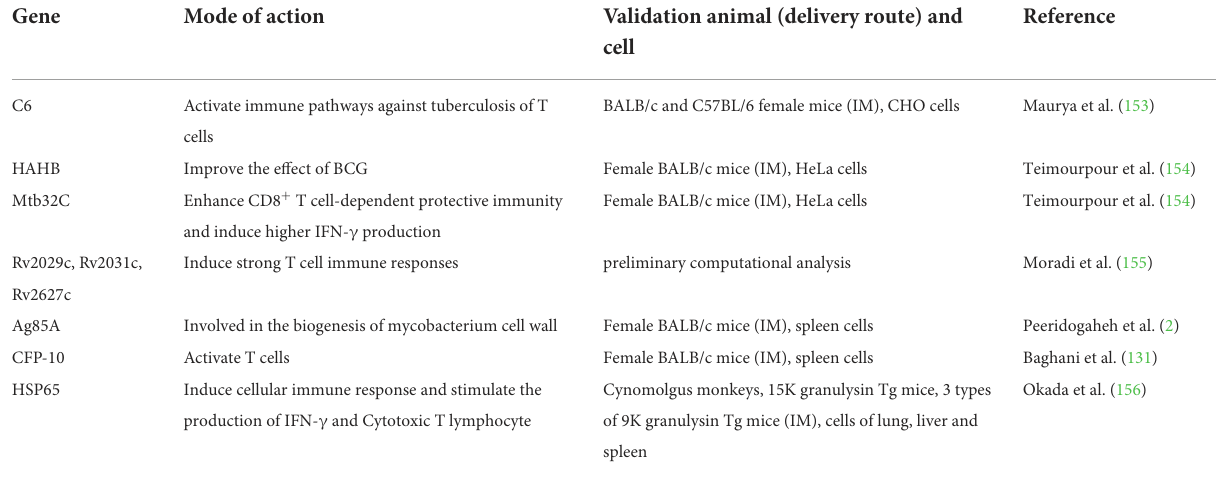
TABLE 4 Summary of genes employed by DNA vaccines against tuberculosis.